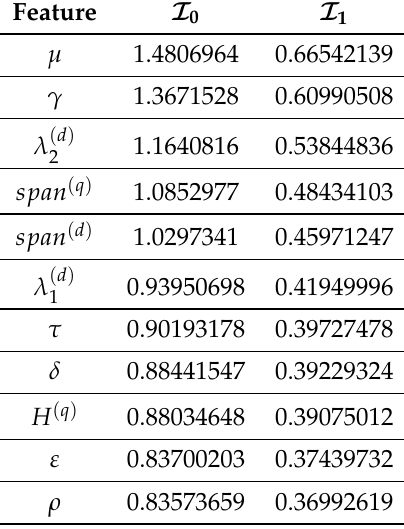
Table 3. RS-2, 2014/04/23: Relevance for distinguishing all different classes (all-class-relevance) . I 0 denotes I ( X | Class ( all )) and I 1 denotes I ( X | Class ( all )) /